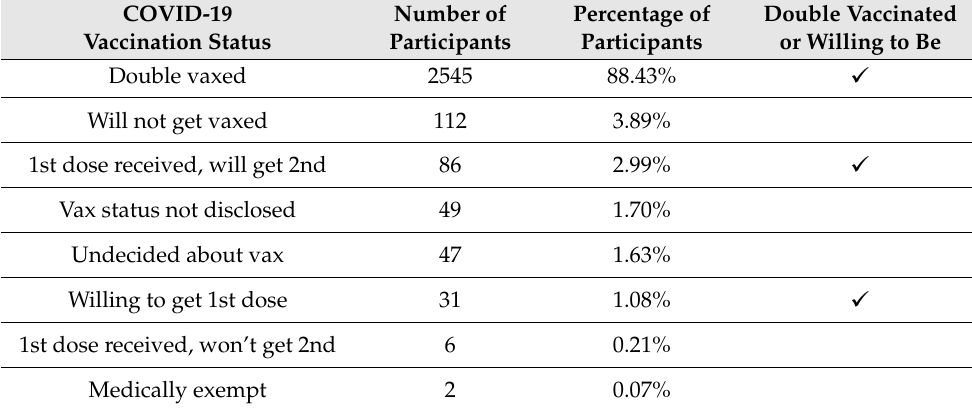
Table 1. Vaccine Status and Categorisation of participants.